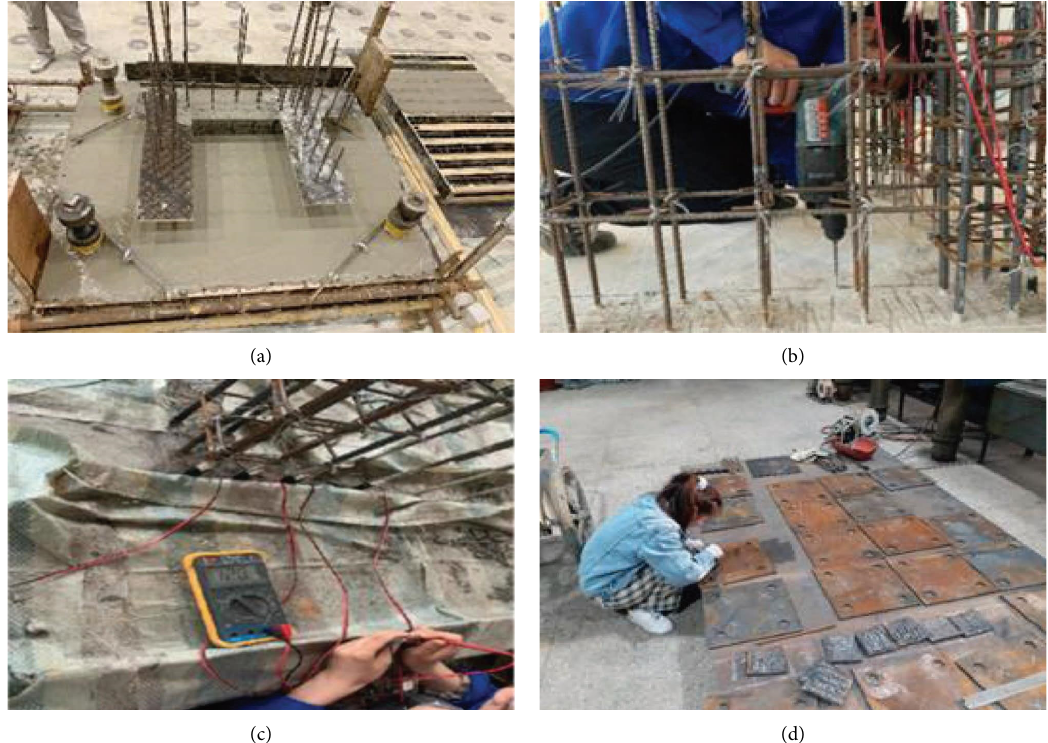
Figure 9: Template support for preliminary work. (a) Pre-embedded thread sleeve. (b) Chiseling the connection surface. (c) Detection strain gauge. (d) Making embedded parts.